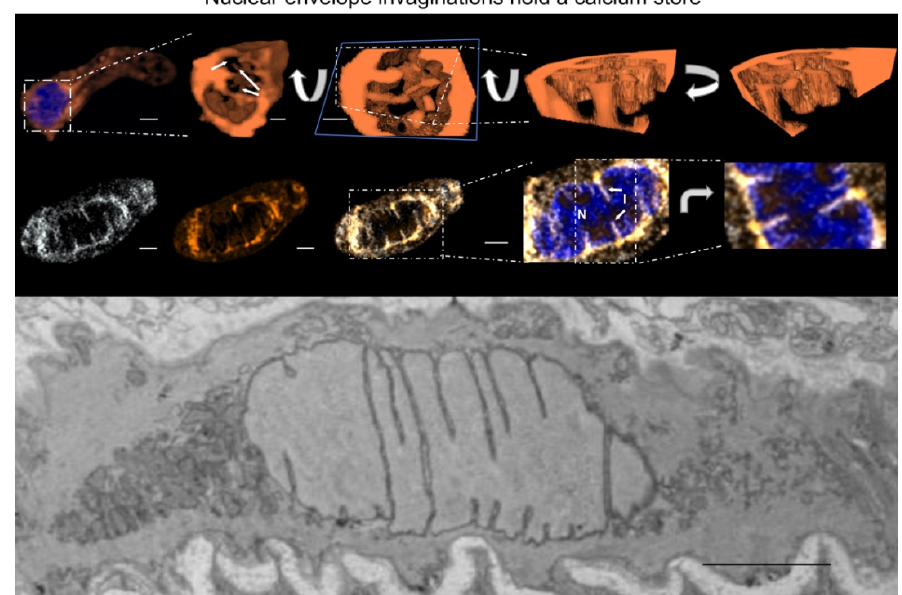
Figure 11. Upper panels show (from left to right) nuclear invaginations at differing orders of magnification, in sections through the nucleus of a pulmonary arterial myocyte in which the lumen of the sarcoplasmic reticulum has been loaded with Calcium Orange (Scale bars from left to right, 2 μ m, 1 μ m, 1 μ m). Middle panels show ER tracker and Calcium Orange co-labelelling of nuclear invaginations. Draq5 identifies the nucleus (blue) in each case (Scale bars, 2 μ m). Lower panel, electron micrograph shows nuclear invaginations in a pulmonary arterial myocyte in-situ in a pulmonary artery section (Scale bar, 2 μ m).